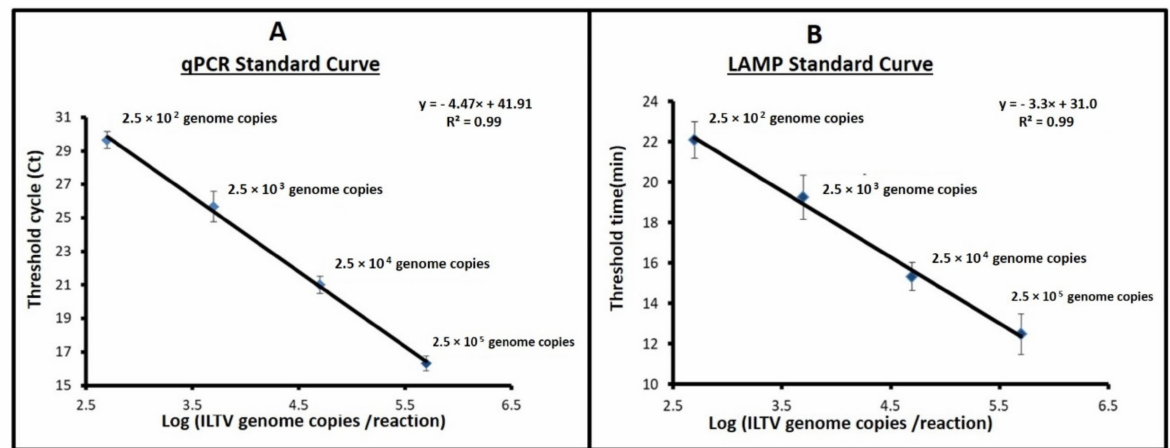
Figure 3. Quantitative detection of ILTV with real-time LAMP and qPCR: The PCR threshold cycle ( A ) and the LAMP threshold time (minutes) ( B ) as functions of the log of ILTV concentration (genomic DNA copies per reaction). n =